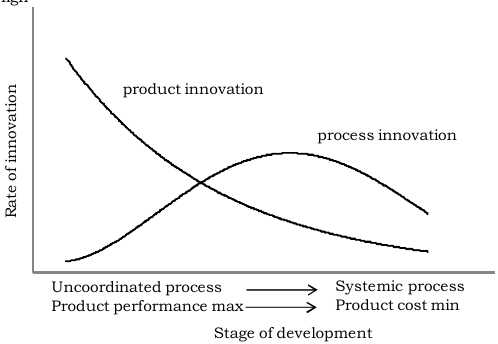
Figure 2. A-U model in Abernathy and Utterback (1978) From “Patterns of industrial innovation,” by W. J. Abernathy and J. M. Utterback, 1978, Technology Review , 80 (7), p. 40. Copyright 1978. Reprinted by permission conveyed through Copyright Clearance Center,